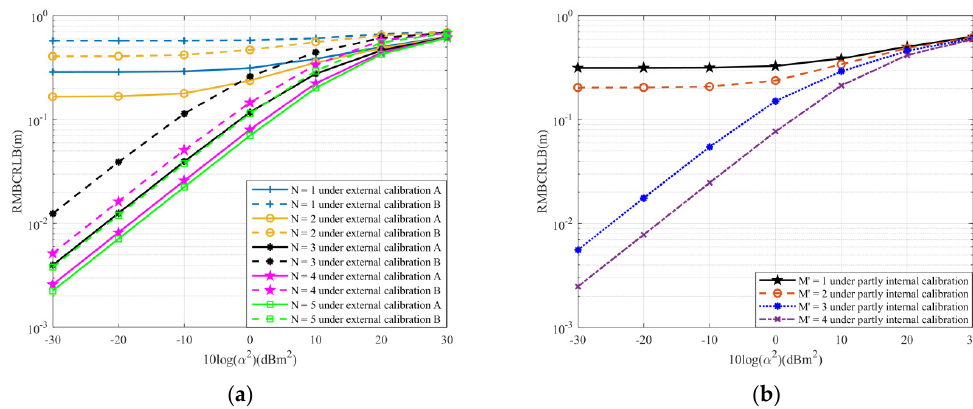
Figure 6. The RMBCRLBs for configuration calibration versus 10log( α 2 ) under different numbers of auxiliary sources and of assumed known sensors when σ 2 = 0.5m 2 . ( a ) The RMBCRLBs versus 10log( α 2 ) under different numbers of auxiliary sources. ( b ) The RMBCRLBs versus 10log( α 2 ) under different numbers of assumed known sensors.